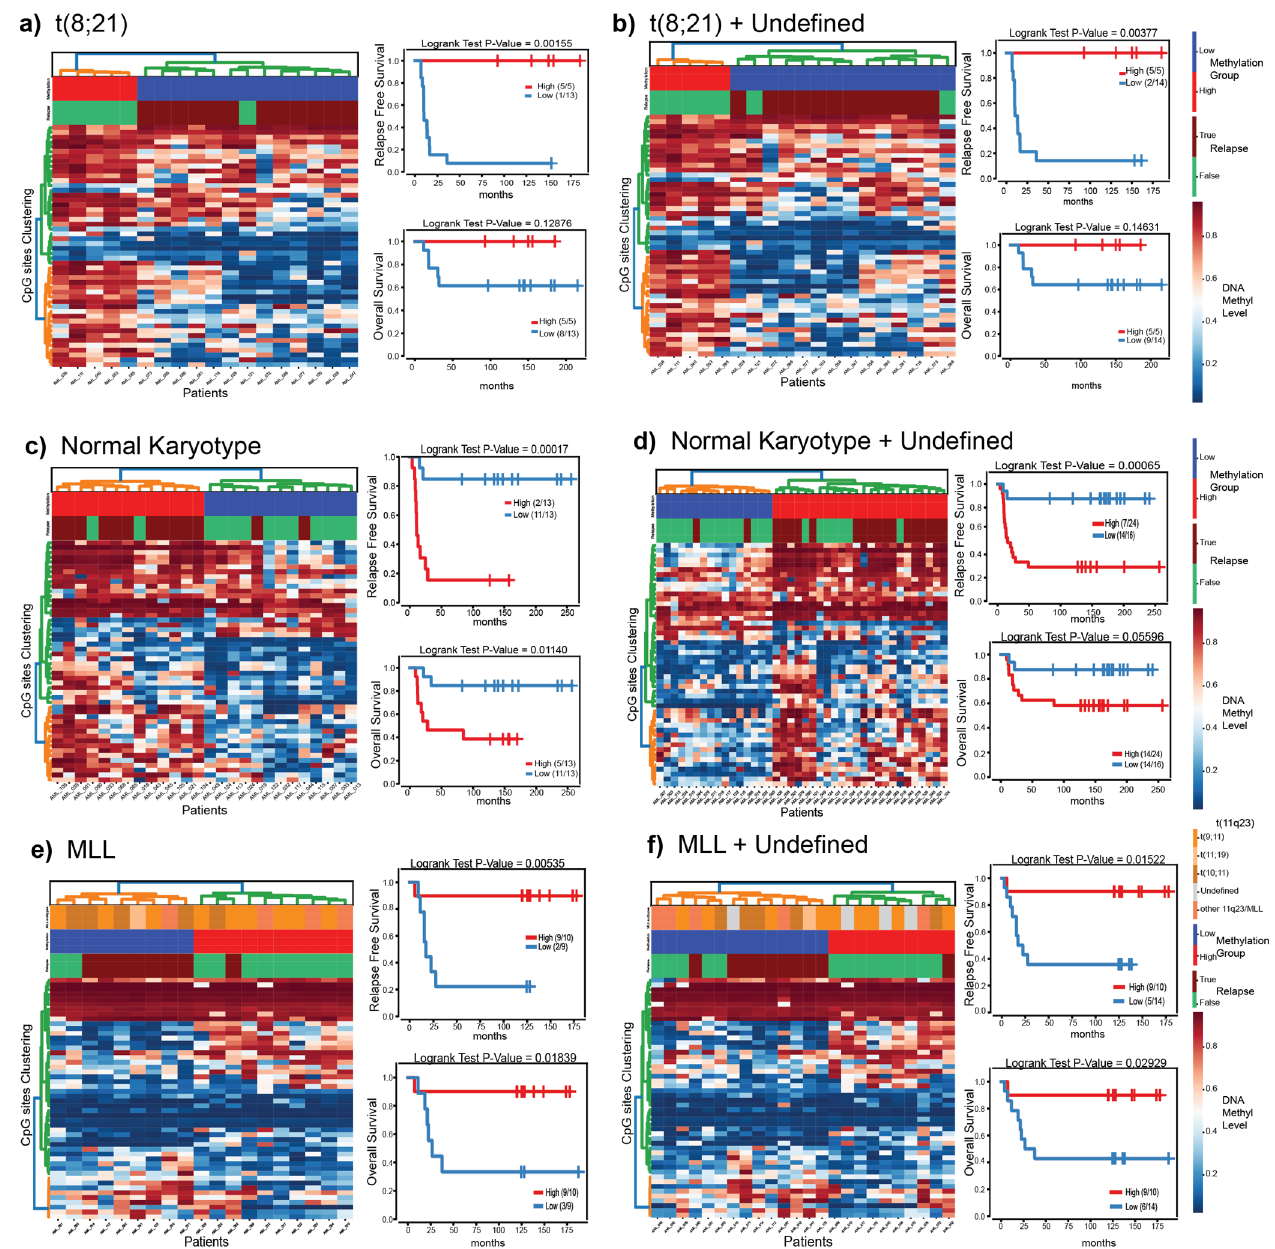
Figure 4. Survival analysis for t(8;21)/ RUNX1-RUNX1T1 ( a , b ), NK ( c , d ), and MLL/KMT2A -rearranged ( e , f ) patient samples based on the 50 most significant CpGs that separate the diagnostic samples of patients who later went on to relapse from those who did not. Panels a , c , and e contain patients with a confirmed diagnostic subtype (diagnostic-known). Panels b , d , and f contain diagnostic-known in addition DNA methylation predicted samples from the undefined group. In each panel, the heatmap (left), is ordered by hierarchical clustering. Samples along the x -axis are split into two groups color coded by high (red) or low (blue) overall methylation level. The numbers in the legend represent the fraction of patients who did not experience an event. Kaplan–Meier curve for relapse free survival analysis (upper right) and overall survival (lower right) of the two groups identified by clustering. The x -axis represents the time until event (months) and events are plotted on the y -axis.